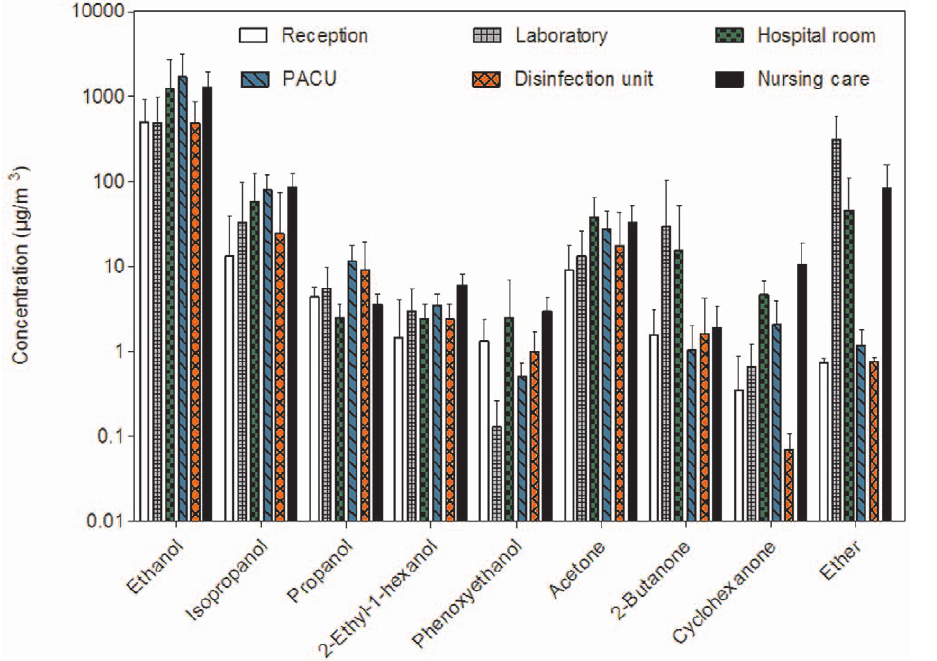
Figure 3. Comparison of alcohols, ketones and ethers concentrations (mean ± SD on a logarithmic scale) in the six sampling sites.